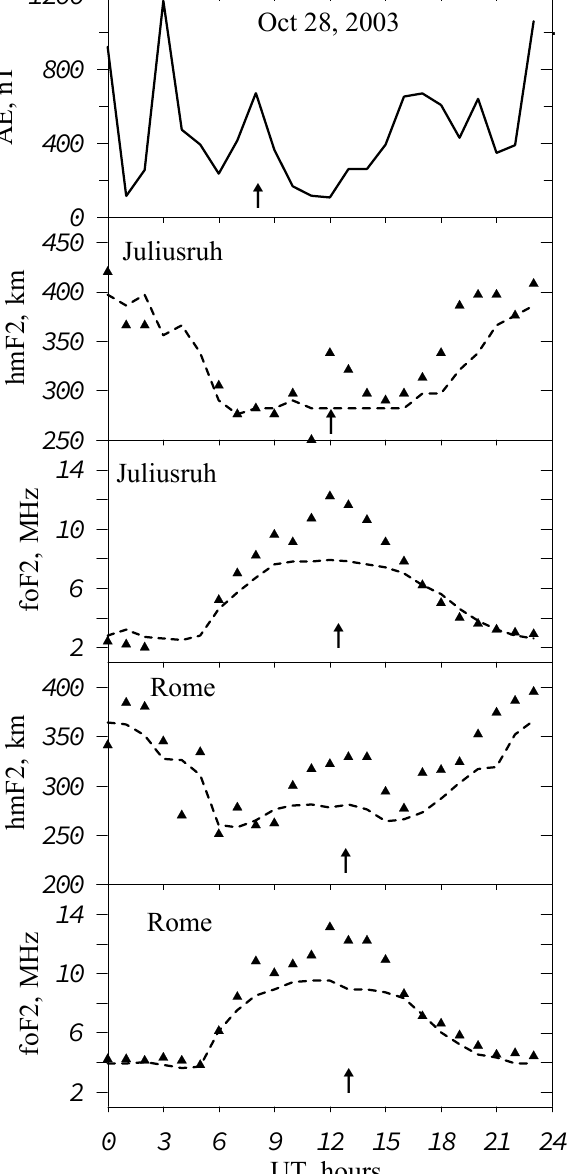
Fig. 2. Fig. 2. Observed variations of AE-index, hm F2, and fo F2 at Julius- ruh and Rome on 28 October 2003. The TAD was launched by the upsurge of the auroral activity around 08:00UT and its passage (arrows) is seen in hm F2 and Nm F2 variations at the two stations. Dashes – median